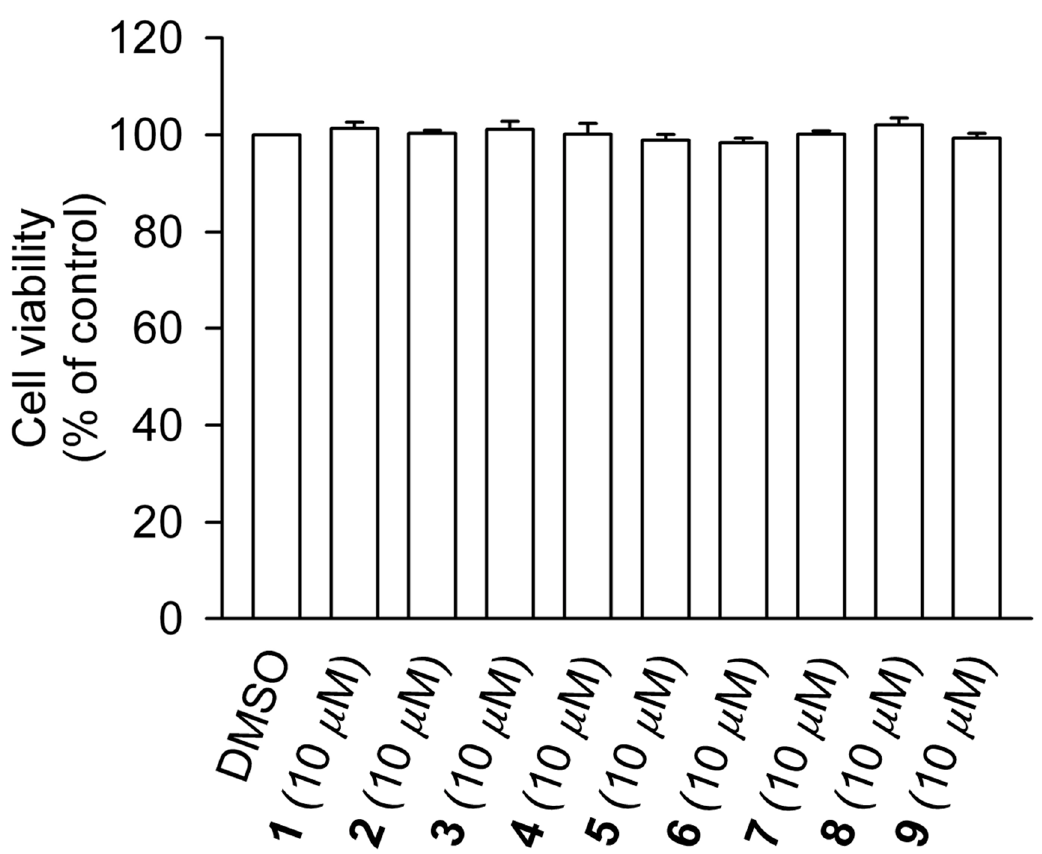
Figure 4. Compounds 1 – 9 do not cause LDH release in human neutrophils. Human neutrophils were incubated with DMSO (as a control) or compounds 1 – 9 (10 µ M) for 15 min. Cytotoxicity was evaluated by LDH release. All data are presented as the means ± S.E.M. ( n = 3).